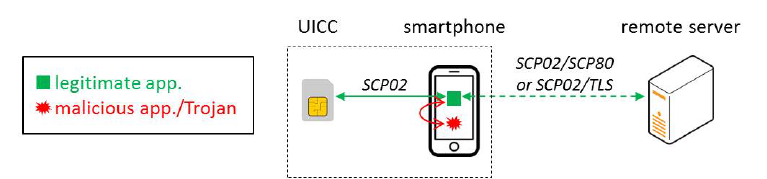
Figure 4: Padding oracle attack targeting an